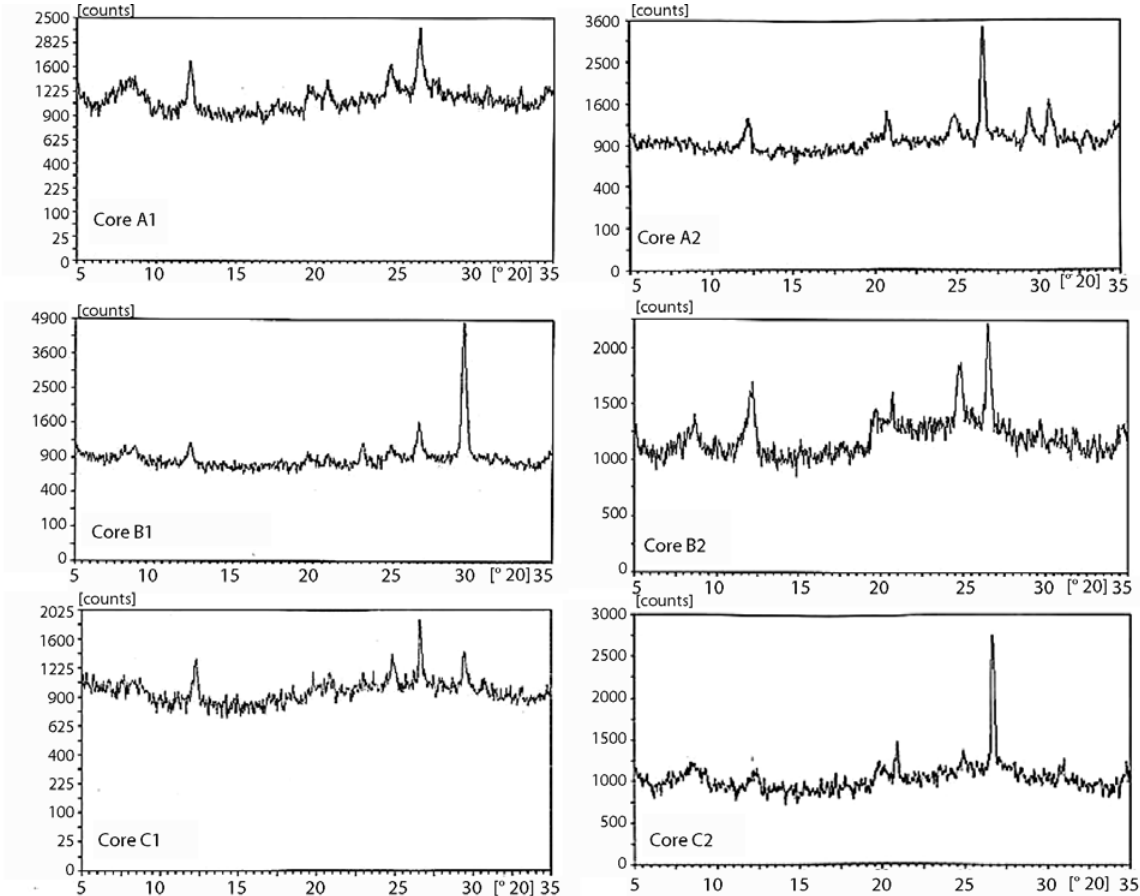
Fig. 4. X-ray diffraction diagrams in cores taken from these wells